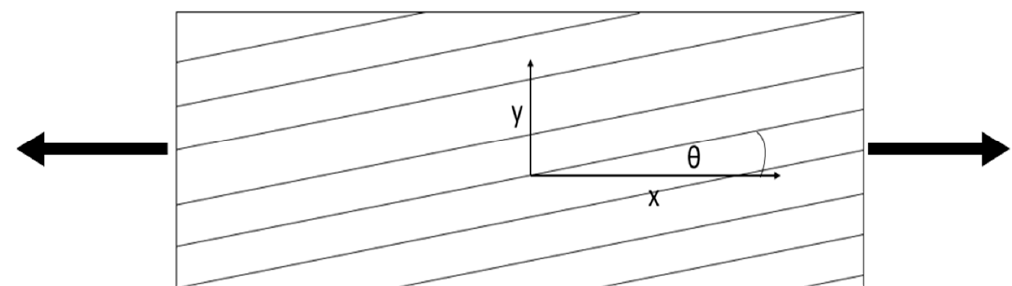
Figure 4. Scheme of the structure of specimens for which the fatigue lifetime was analyzed with axial loading directions.